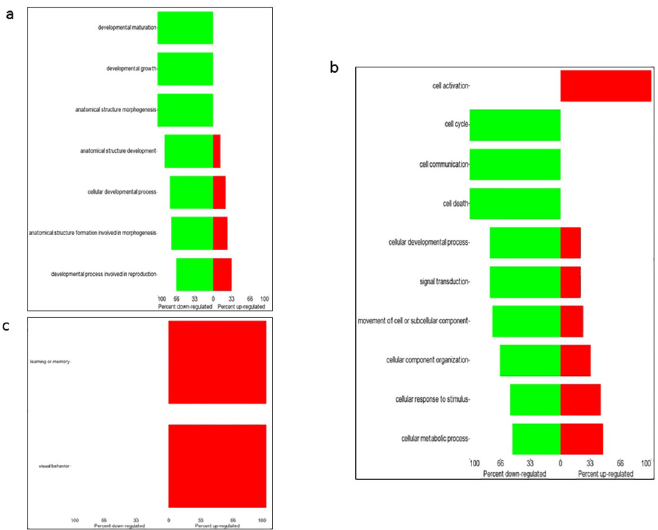
Fig 5. Forest plot of GO for DEGs in biological processes in female Cln3 Δ ex7/8 mouse brain. Gene expression in GalCer versus vehicle-treated female Cln3 Δ ex7/8 mouse brain. The criterion for differential expression assumes a p- value < 0.05. Forest plots of biological processes of (a) developmental, (b) cellular, and (c) behavioral processes depict percentage of down- (green) or up-regulated (red) genes in each category.